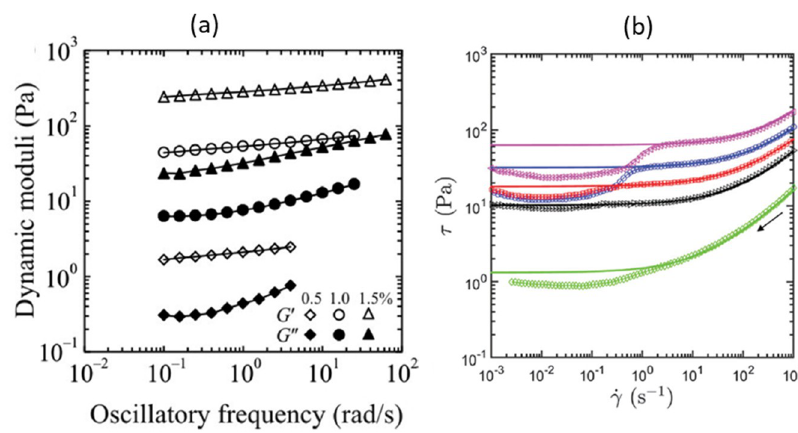
Figure 4. ( a ) Storage G’ and loss G’’ moduli as a function of the oscillatory frequency for TEMPO-oxidised CNF suspensions at different concentrations (0.5–1.5 wt%). (Adapted from Nechyporchuk et al. [99]. Copyright 2015 Springer Science + Business Media Dordrecht. With permission of Springer). ( b ) Macroscopic flow curves (shear stress τ as a function of the shear rate ̇ ) obtained for various TEMPO-oxidised CNF suspensions concentrated at 0.3, 0.56, 0.7, 0.85, and 1 wt% using a plate–plate rheometer. In graph ( b ), the solid lines represent the fits of the Herschel–Bulkley model τ = τ 0 + k where k and n are the consistency parameter and the flow index, respectively. (Adapted from Martoïa et al. [100] with permission from the Royal Society of Chemistry).